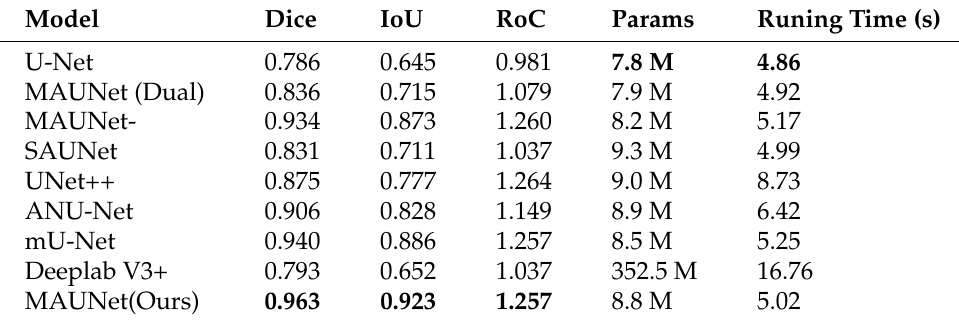
Table 4. The quantitative comparison of the segmentation results on dataset SPMID. The best results are highlighted in